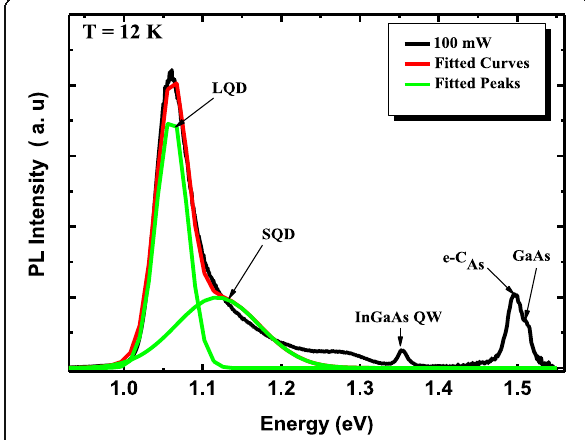
Fig. 3 Second derivative spectrum of imaginary part ( ϵ 2 ) of dielectric function as function of the photon energy for the InAs/InGaAs QD heterostructure. The transition energies arising from InAs QD layers and GaAs layers are indicated [10]